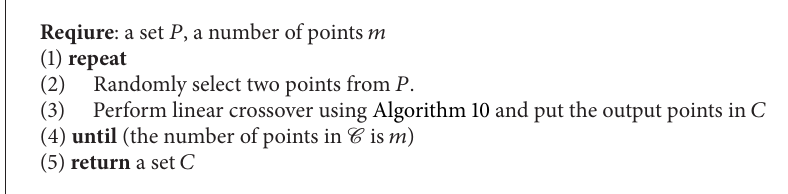
Algorithm 9: Create a new set of points from a given set 𝑃